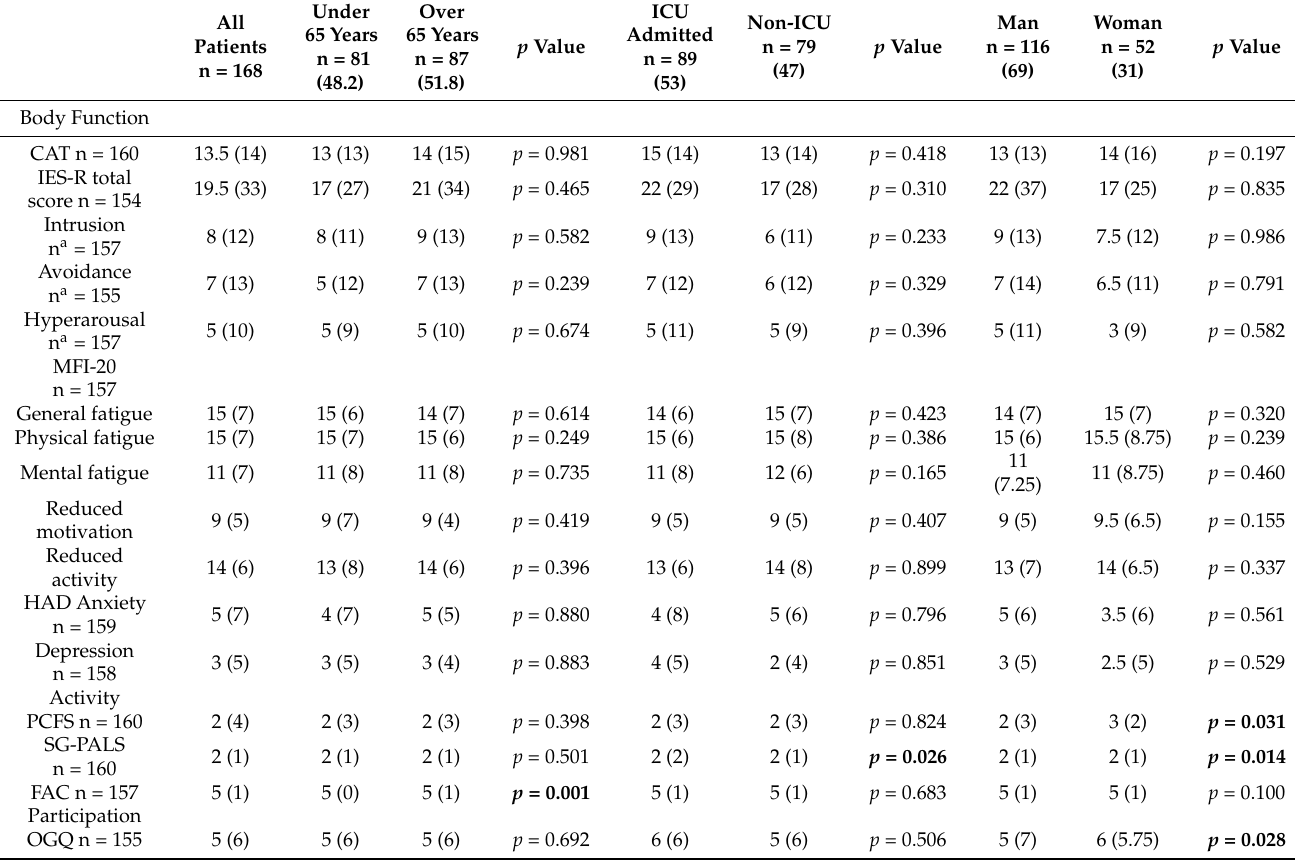
Table 2. Patient reported outcome measures at 3-month